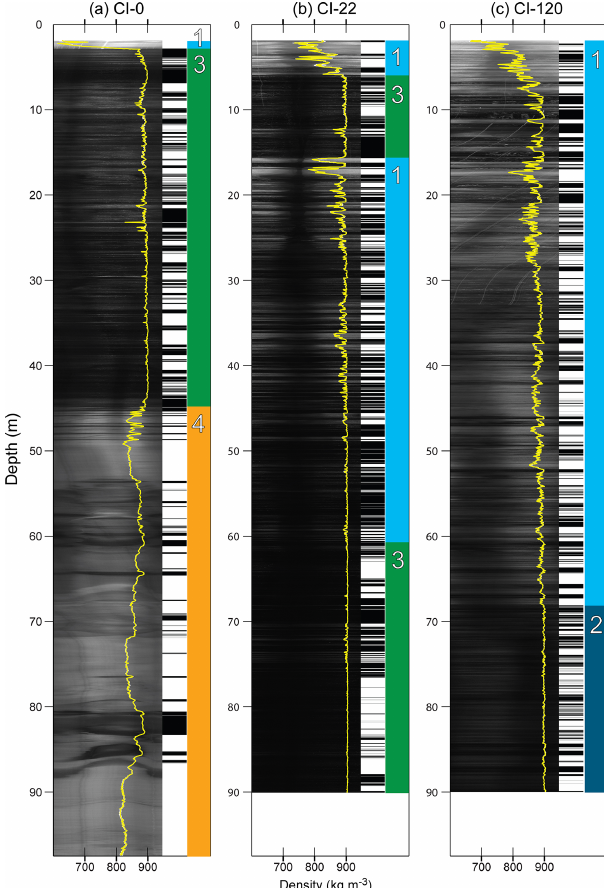
Figure 2. OPTV images, density profiles, unit classifications, and binary thresholding output for boreholes at (a) CI-0, (b) CI-22, and (c) CI-120. The grey shading represents the recorded luminosity of the ice, and the white profile represents the inferred density using the x -axis scale. The coloured panels are the different ice type units referred to in the text. The black stripes in the barcode-like panels show the presence of refrozen ice determined via a binary thresh- olding analysis which was deemed to perform poorly for Unit 3 ice (Ashmore et al., 2017). The figures are reproduced from Ashmore et al. (2017) where the methods are described in more detail.